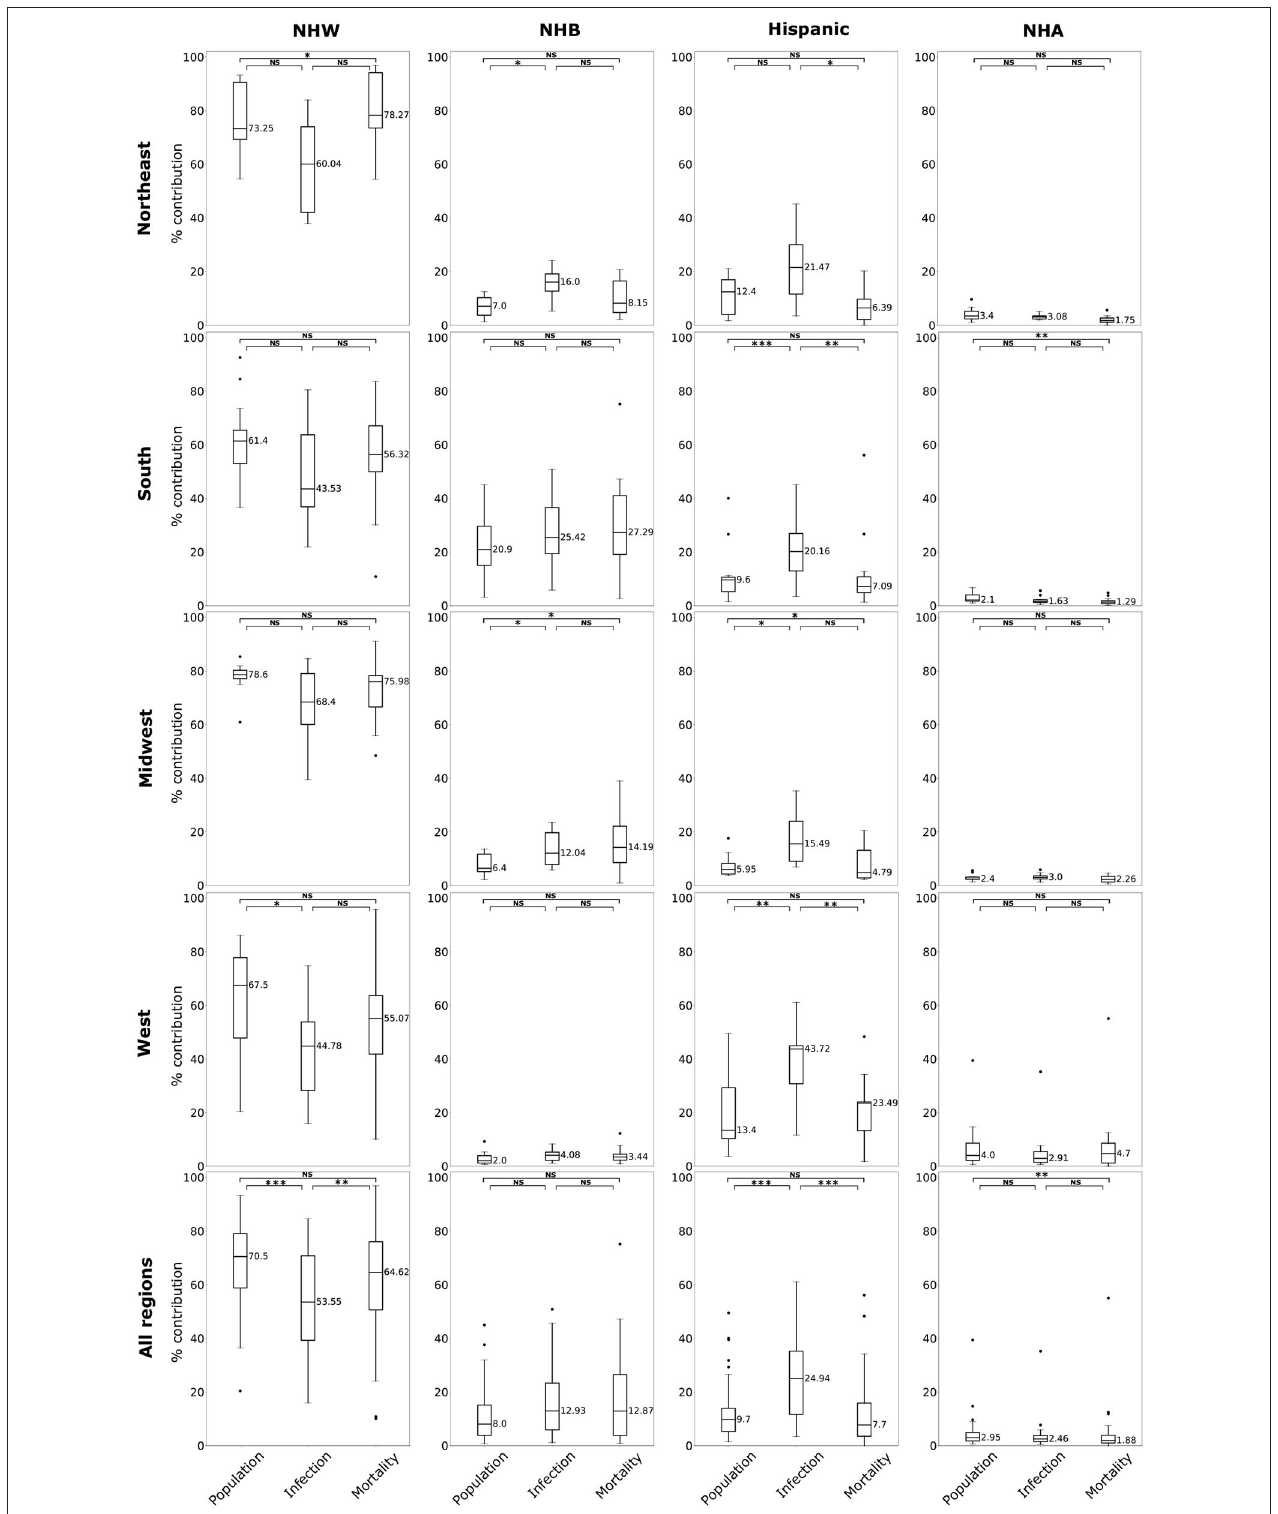
FIGURE 2 | Box plots of population, relative infection %, and relative mortality % in each of four US regions, and combining all regions for NHW, NHB, Hispanic and NHA groups. Horizontal bars represent medians. “*” significance at p < 0.1, “**” significance at p < 0.05, “***” significance at p < 0.01, NS, not significant (Kruskal-Wallis tests followed by Dunn’s